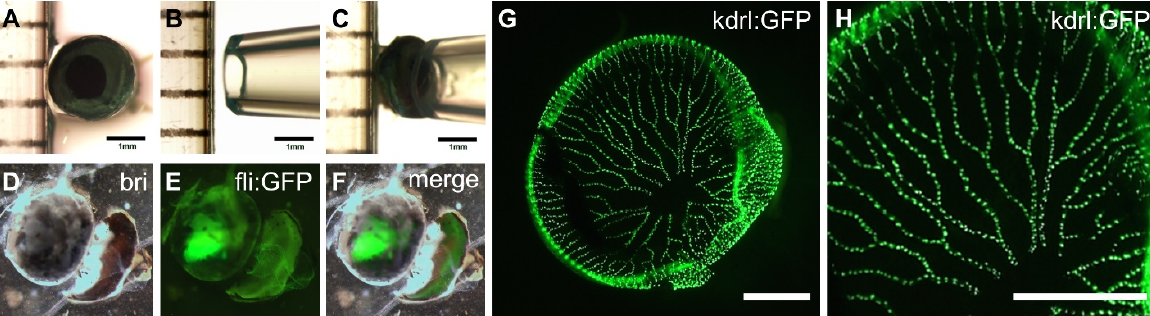
Figure 1. A rapid and simple method for the separation of the intact retinal vasculature from adult zebrafish eyes. ( A – F ) The simple procedure of detaching the whole retinal vasculature from a dissected eye using a 1 mL micropipette tip. After the removal of the lens, the intact retinal vasculature was examined by high-resolution microscopy. ( G , H ) Fluorescent image of whole retinal vasculature separated from adult transgenic zebrafish line Tg[kdrl:EGFP] , showing fine blood vessel structures. Scale bars; 1 mm for ( A – F ) and 200 µ m for ( G , H ).